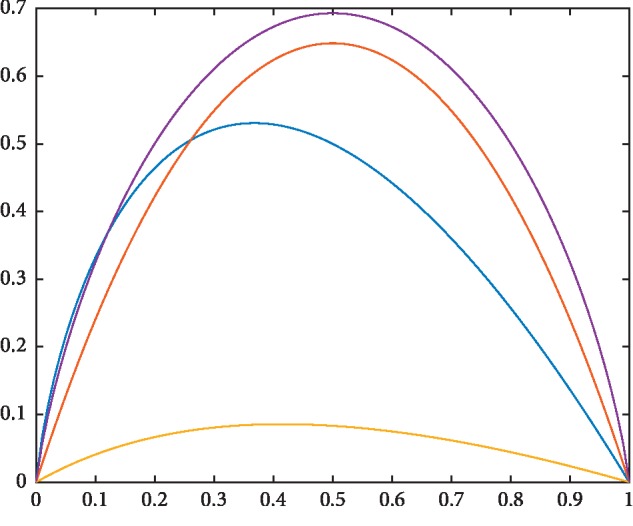
Yellow curve: y = x/(1 + x) − x/2; blue curve: y = −xlog(x); purple curve: y = −[xlog(x) + (1 − x)log(1 − x)]; orange curve: y = x ∗ exp(1 − x) + (1 − x)exp(x) − 1.